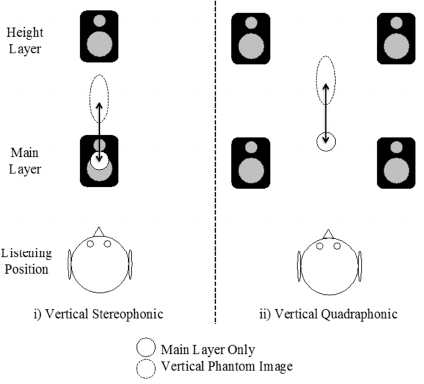
Figure 12. Illustration to show how presentation method would not affect localisation thresholds despite the presence of the phantom image elevation effect.